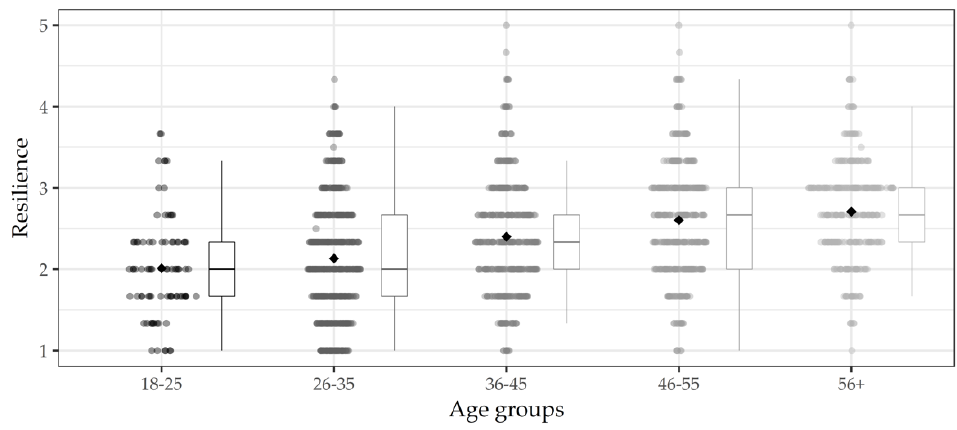
Figure 1. Boxplot of resilience scores across age groups. The response scale ranged from 1 = much worse to 5 = much better, with 3 = no change (relative to the months before the COVID-19 pandemic). To test the robustness of age differences in resilience across the genders, staff groups, expat status, and living situation, we used Hayes’ [54] PROCESS Macro for SPSS (Model 1). We ran separate moderation models for each potential moderator. Age differences in resilience were not moderated by gender ( b = 0.027), staff group ( b = 0.056), or expat status ( b = 0.032, all 95% CIs included 0, all p s > 0.05). However, age differences were moderated